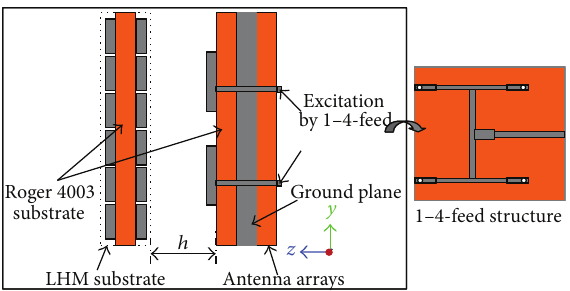
Figure 19: Structure of FL-LHM antenna arrays using 1–4-feed structure.